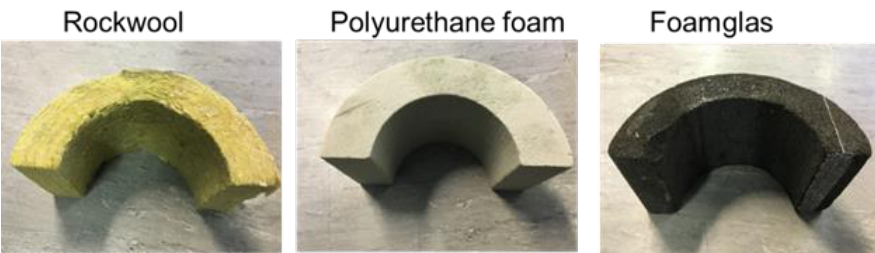
Figure 1. Photographs of the three types of insulation investigated in this work.